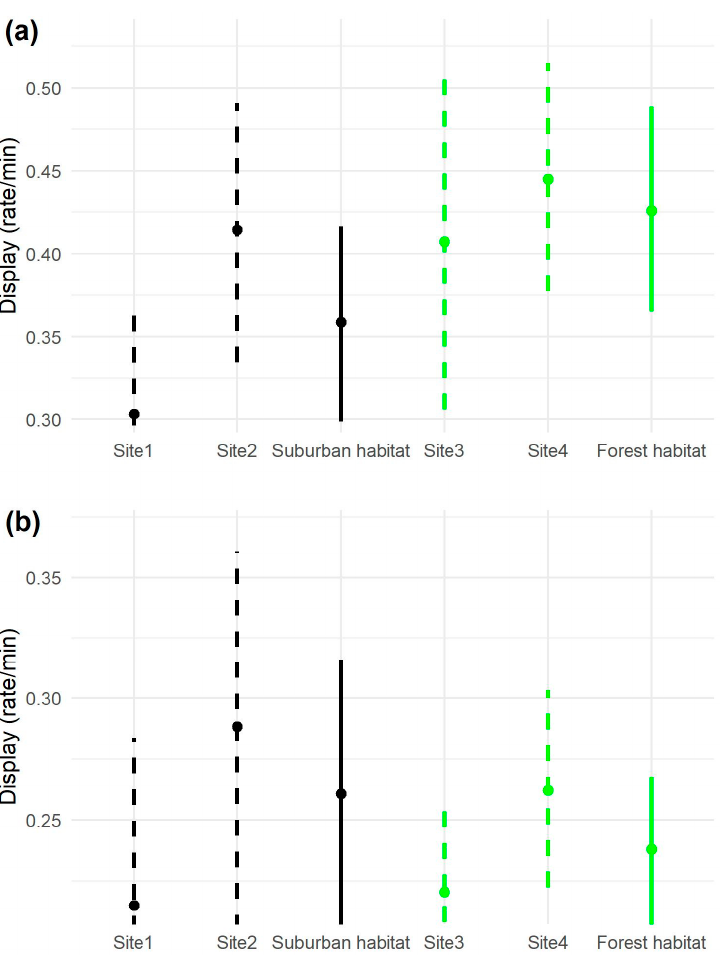
Figure 8. Display rate (arcsine square root transformed) in ( a ) males and ( b ) females of Anolis homo- 1: Guanajay, Site 2: San Jos é de Las Lajas, Site 3: Sierra del Rosario, and Site 4: Escaleras de Jaruco. lechis from suburban (black) and forest (green) population. Sampled sites are referred to as Site 1: Guanajay, Site 2: San José de Las Lajas, Site 3: Sierra del Rosario, and Site 4: Escaleras de Jaruco. Vertical bars indicate confidence intervals at Vertical bars indicate confidence intervals at 95%.